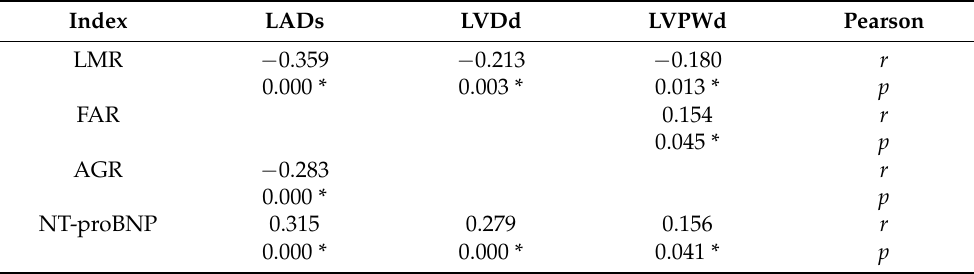
Table 6. Pearson correlation analysis of SII and echocardiography indexes.